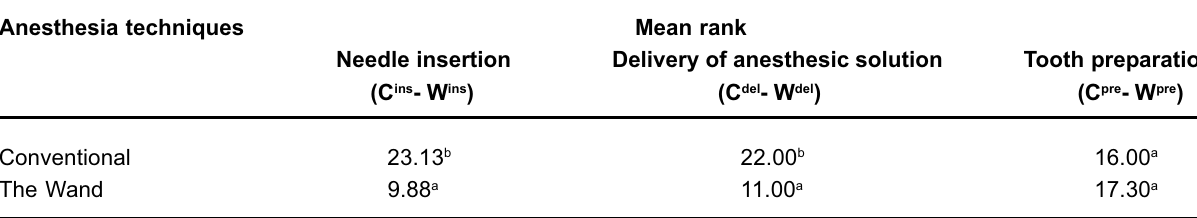
TABLE 4- Differences between the two anesthesia techniques for pain level